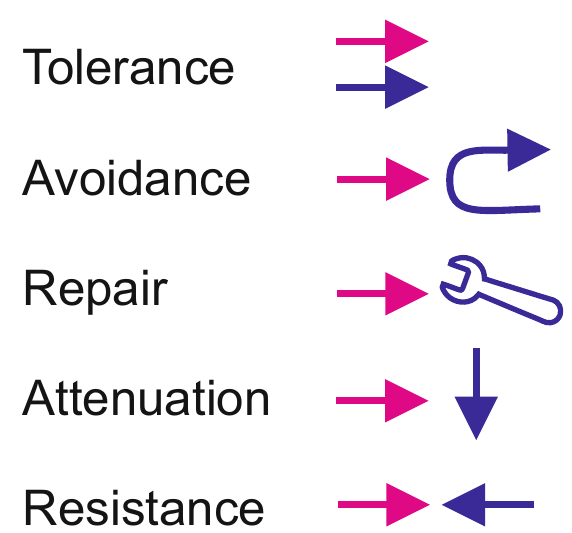
Figure 3. Graphical description of TARAR countermeasures. Perturbation is shown in red and TCMs in blue. The perturbation co-exists in tolerance. In avoidance the TCMs protect the system e.g. by preventing interaction with potentially harmful substances. Repair mechanisms renew or reconstitute the system, while attenuation processes reduce the effect of perturbation. Resistance mechanism oppose the effects of a